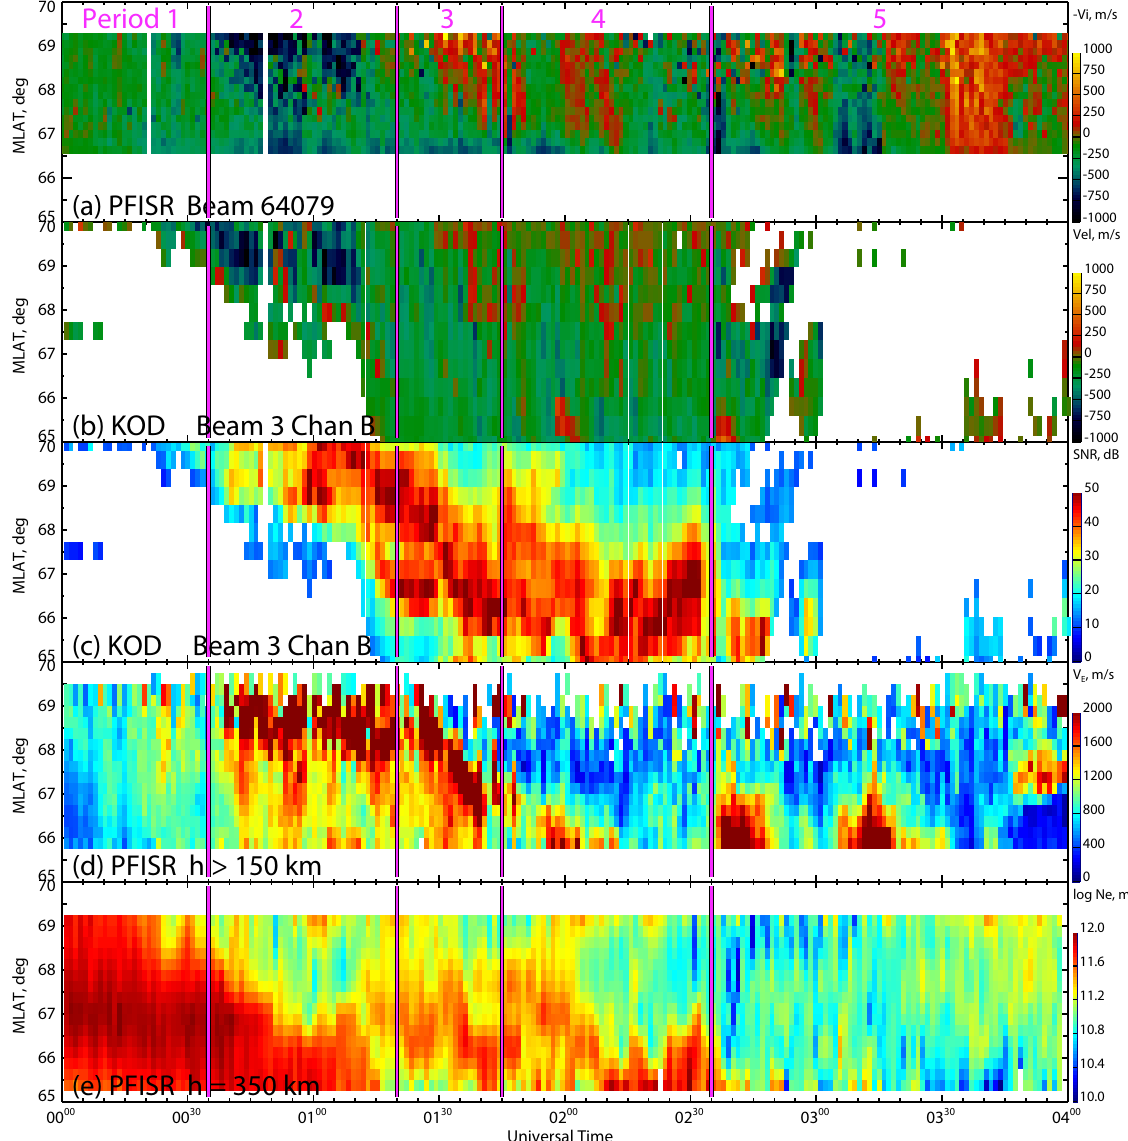
Figure 2. Magnetic latitude keograms of (a) the negative of the line-of-sight (l-o-s) component of the ion drift velocity measured by PFISR in beam 64079; (b) the Doppler velocity measured by KOD in beam 3 and in Channel B and post-integrated over the PFISR integration periods; (c) the KOD signal-to-noise ratio (SNR) in beam 3, Channel B; (d) the PFISR convection drift magnitude V E derived from LP data in all beams; and (e) the PFISR electron density N e at an altitude of 350km.